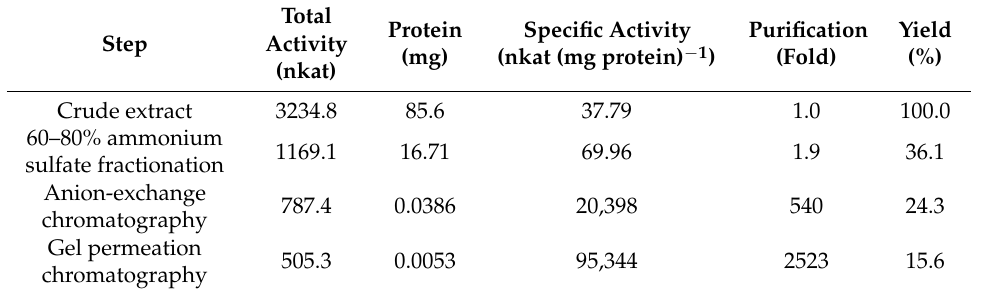
Figure 1. Stability of yeast P5C reductase in crude extracts and in purified preparations. ( a ) Crude extracts were prepared in the presence or in the absence of 1 mM DTT, and stored on ice; the specific activity of the enzyme was measured at increasing time, and expressed as percent value of activity at time 0 (102.7 ± 0.7 nkat mg − 1 protein, evaluated using NADPH as the electron donor). Two different experiments were performed, each with 3 replicates. Data were combined and plotted as mean values ± SE. ( b ) Active fractions from a DEAE-Sephacel column were pooled; aliquots were mixed with the same volume of different solutions, as indicated, and stored on ice. The specific activity of the enzyme was measured at increasing time and expressed as percent value of activity at time 0 (48.95 ± 0.37 µ kat mg − 1 protein). Data are mean ± SE over 3 independent replicates. Table 1. Purification of Saccharomyces cerevisiae P5C reductase 1